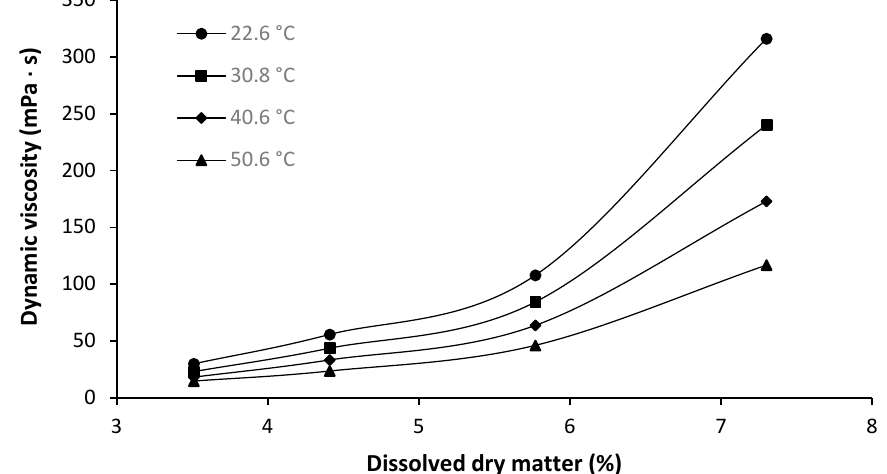
Figure 8. Dynamic viscosity of aqueous solutions of arabinoxylan isolate, obtained by alkaline/hydrogen peroxide extraction, as a function of dry matter. Determination was carried out at a shear rate of 179.6 s − 1 and temperatures between 22.6 °C and 50.6 °C.